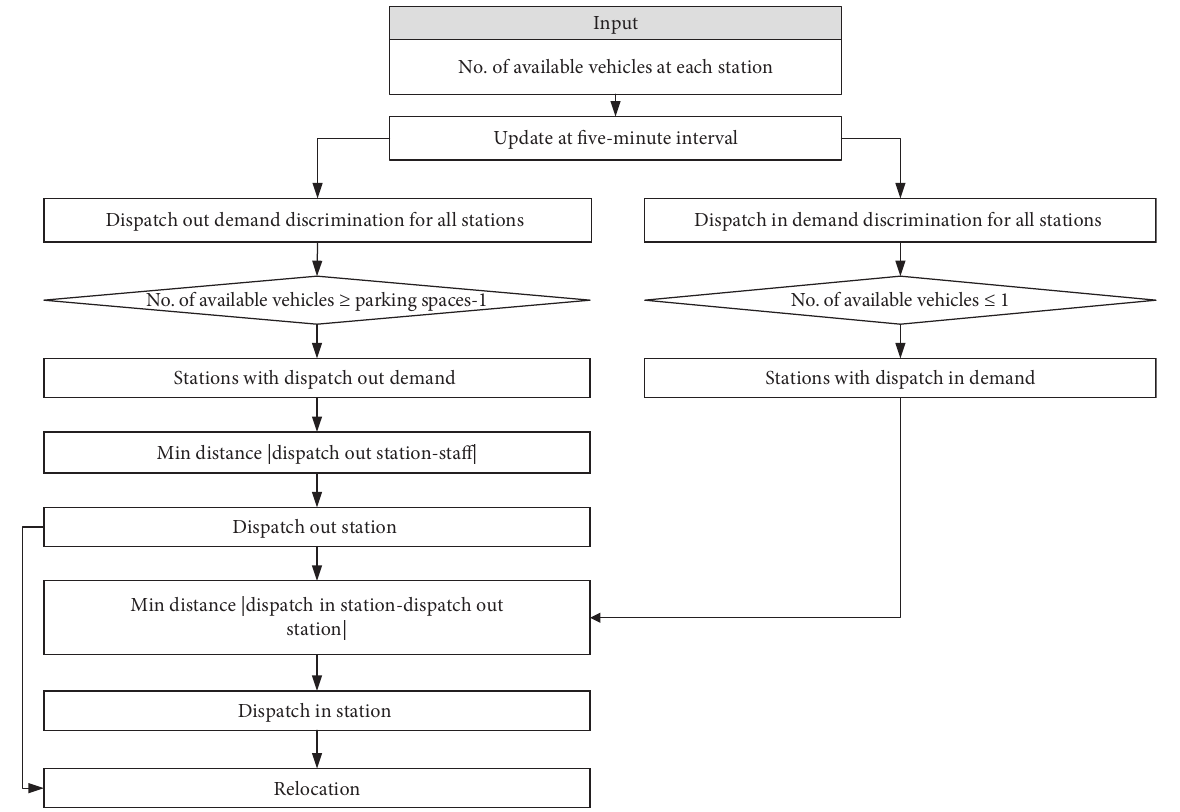
Figure 8: Relocation with no prediction. Table 4: Results of three ways of